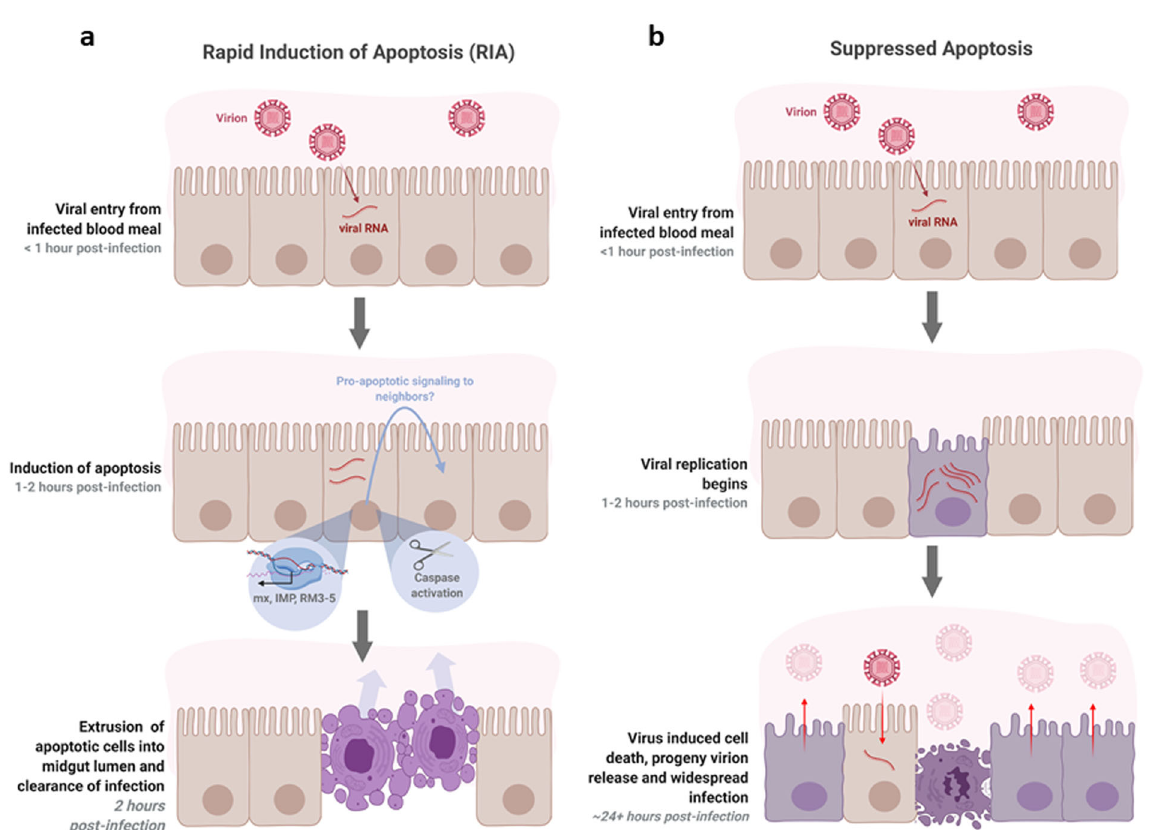
Fig. 5 Hypothesized model of antiviral apoptosis in the Aedes aegypti midgut. a RIA of infected cells in the midgut epithelium within 2 hours of an infected blood meal arrests viral replication before progeny virions can be produced and suppresses infection. The clustered appearance of apoptotic cells may be caused by pro-apoptotic signaling to neighboring cells. b At later timepoints post infection, when infection is widespread throughout the midgut and progeny virions are being produced, death of infected cells may facilitate release of virions from cells and/or from the midgut by degrading the integrity of the epithelium and basal